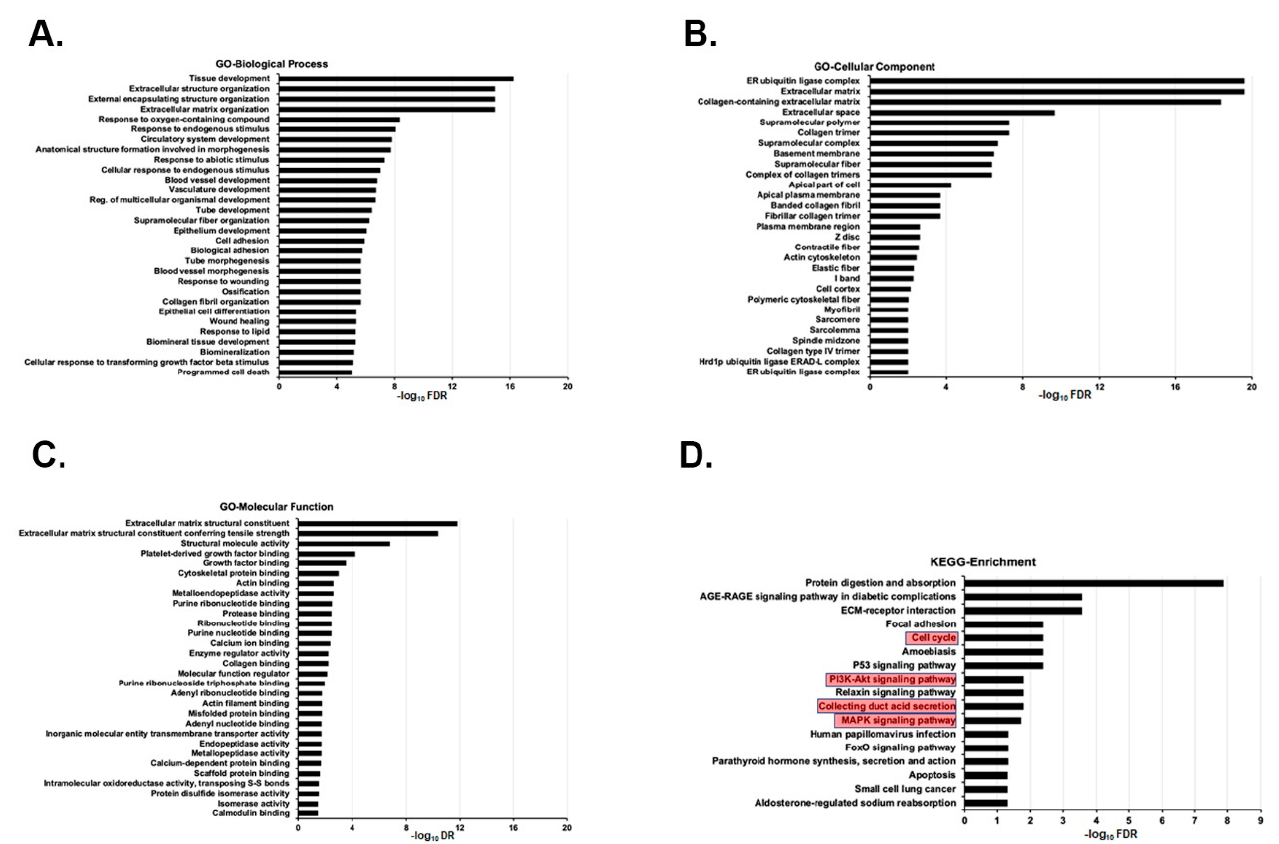
Figure 5. GO analysis of significantly up-regulated genes. Enrichment analysis for the up-regulated genes with fold induction of greater than 1.3 and FDR < 0.05 was performed. The 30 most significant GO terms for ( A ) GO Biological Process, ( B ) GO Cellular Component and ( C ) GO Molecular Function were identified. ( D ) The KEGG enrichment analysis was performed using DEG with fold induction of greater than 1.3 and FDR < 0.05. The results indicate that collecting duct acid secretion, cell cycle, PI3K/AKT and MAPK are among the significantly enriched pathways (bracketed in red boxes). 2.8. Polyamines Levels and Their Synthesis Are Not Affected in the Kidneys of Tsc1 KO Mice Previous studies indicated that cerebral levels of putrescine and activity of ornithine decarboxylase (ODC), a rate-limiting enzyme in polyamine synthesis, are elevated in mice with radial glial cell upon specific ablation of the Tsc2 gene [17]. Metabolomic analysis of the sera and isolated tumor cells of TSC patients with lymphangioleiomy- omatosis (LAM) also demonstrated significant alterations in the levels of polyamine metabolic pathway intermediates [18]. Our results indicate that the levels of putrescine (1.74 ± 0.4 vs. 1.58 ± 0.25 nmol/mg protein), spermidine (7.1 ± 0.6 vs. 8.5 ± 1.8 nmol/mg protein) and spermine (7.4 ± 0.6 vs. 8.9 ± 2.3 nmol/mg protein) in the kidneys of Wt and Tsc1 KO mice were not significantly different (Supplementary Figure S4A). Furthermore, the activity of ODC (115 ± 50 vs. 98 ± 40 pMCO 2 /hr/mg protein) was not significantly altered in the kidneys of Wt and Tsc1 KO mice (Supplementary Figure S4B). Examination of our RNA-seq results also did not reveal any changes in the expression of transcripts associated with polyamine metabolism (Dataset 1). Our results indicate that unlike what was reported in the brain samples of Tsc2 cKO mice and in tumor cells and sera of patients with TSC2 mutations, the renal polyamine levels and polyamine biosynthesis are not significantly altered in Tsc1 KO vs. Wt